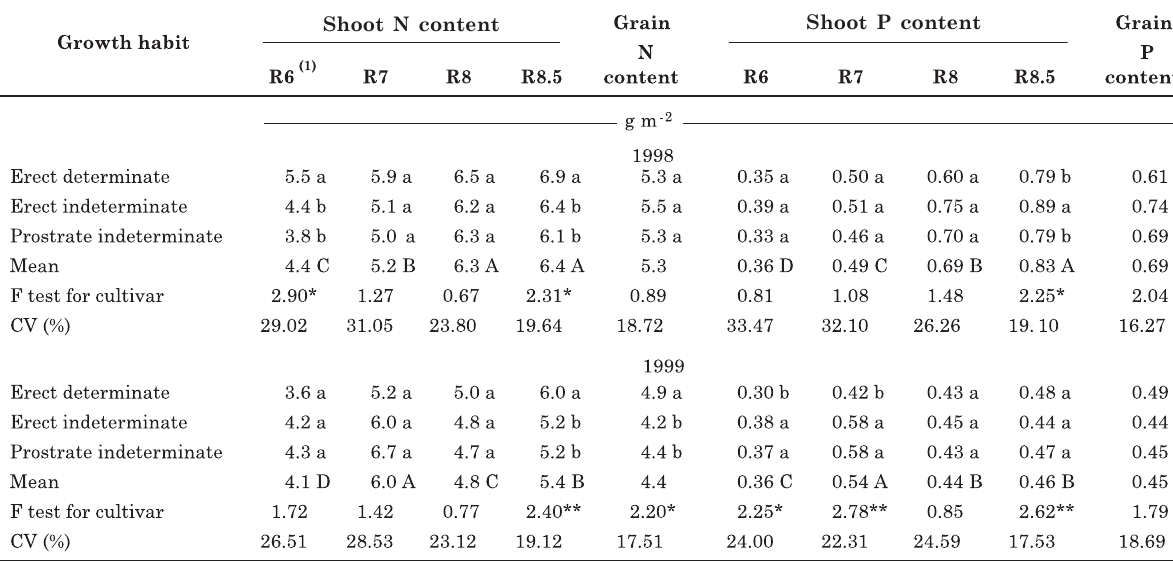
Table 3. Shoot N and P contents at four growth stages, and grain N and P contents at maturity, of common bean cultivars grown in two field experiments (1998 and 1999); cultivars were grouped according to growth